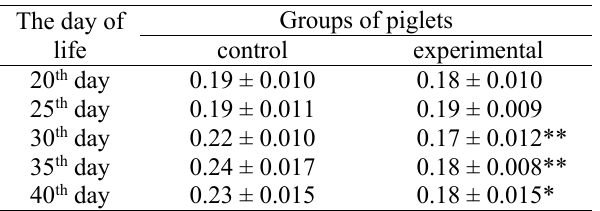
The activity of aspartate-aminotransferase in serum of pig- lets under the action of feed additive “Butaselmevit-plus”, mkat/l (M ± m, n = 5) Groups of piglets The day of life control